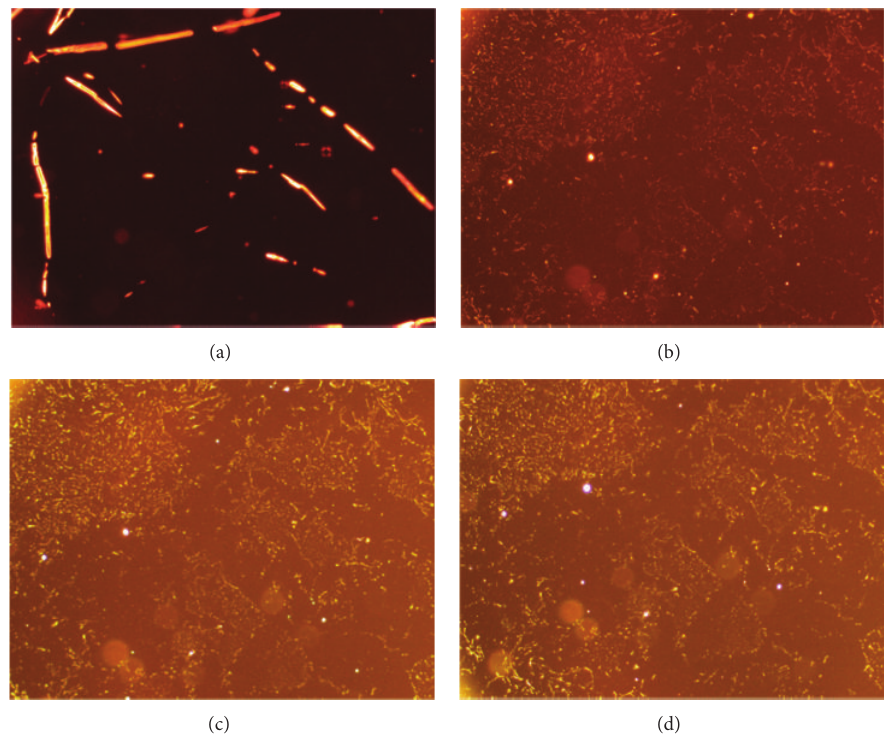
Figure 6: POM images of UFUR/TMBPDE composite resin at different temperatures (100x): (a) 90 ∘ C; (b) 100 ∘ C; (c) 110 ∘ C; (d) 160 ∘ C.